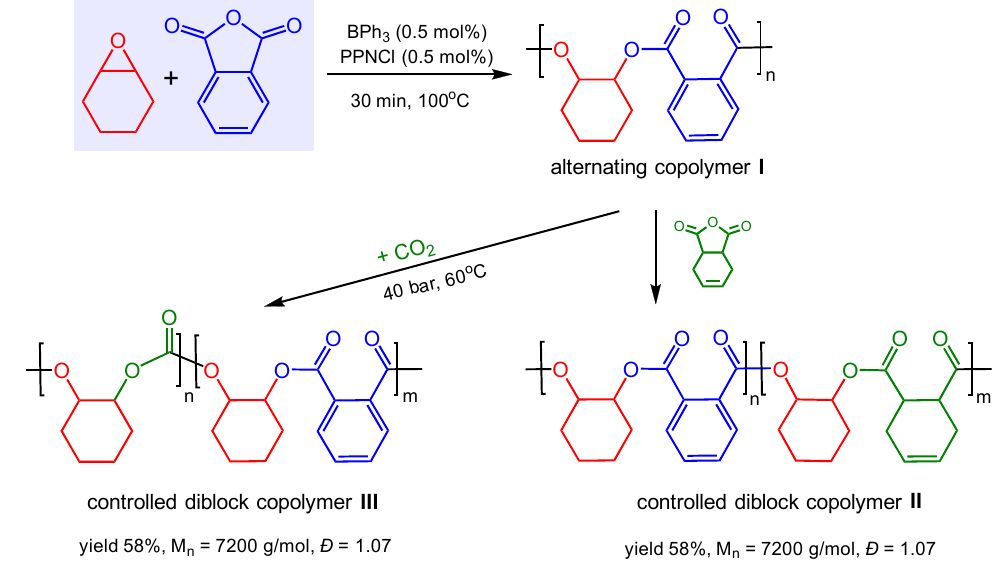
Scheme 5. BPh 3 -catalyzed copolymerization to alternating copolymers and controlled diblock co-